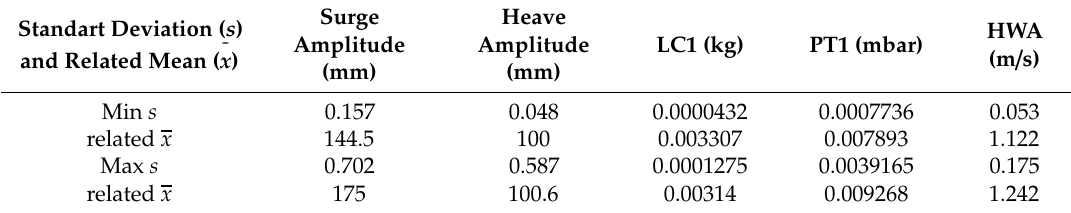
Table 4. Minumum and maximum standart deviations and related mean values of the repeated measurements.